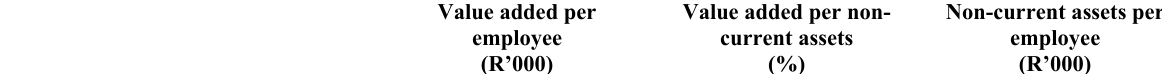
Table 2: Productivity